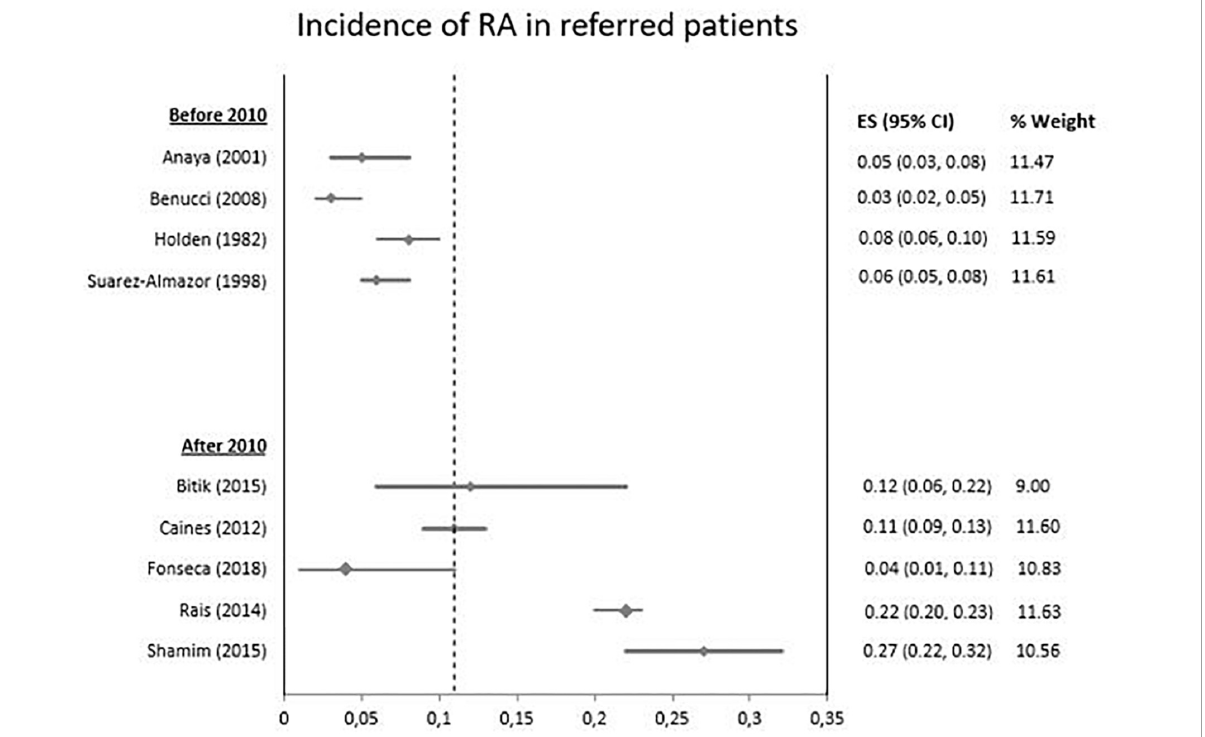
review studies are included in which both